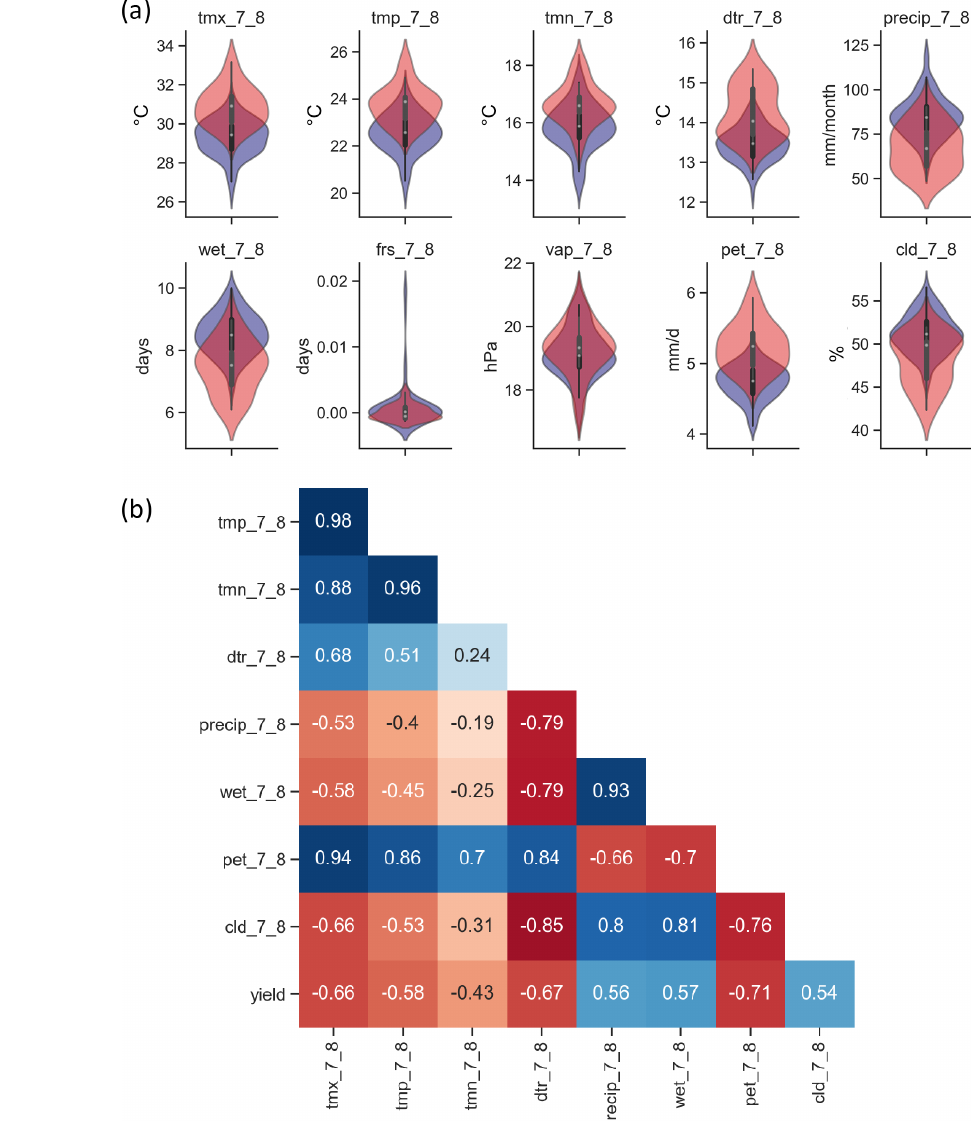
Figure 3. (a) Probability distribution function of monthly values for meteorological conditions of soybean seasons with (red) and without (blue) failures for maximum monthly temperature (tmx), precipitation (precip), diurnal temperature range (dtr), vapour pressure (vap), po- tential evapotranspiration (pet) and cloud cover (cld). Numbers 7 and 8 indicate the months of July and August, respectively. (b) Pearson’s correlation matrix indicating the correlation levels for meteorological variables aggregated along July and August, and crop